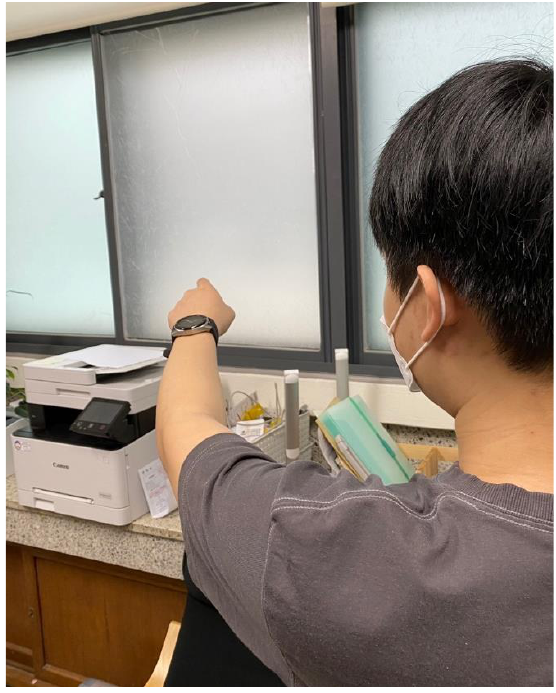
Figure 2. Example of an air-writing